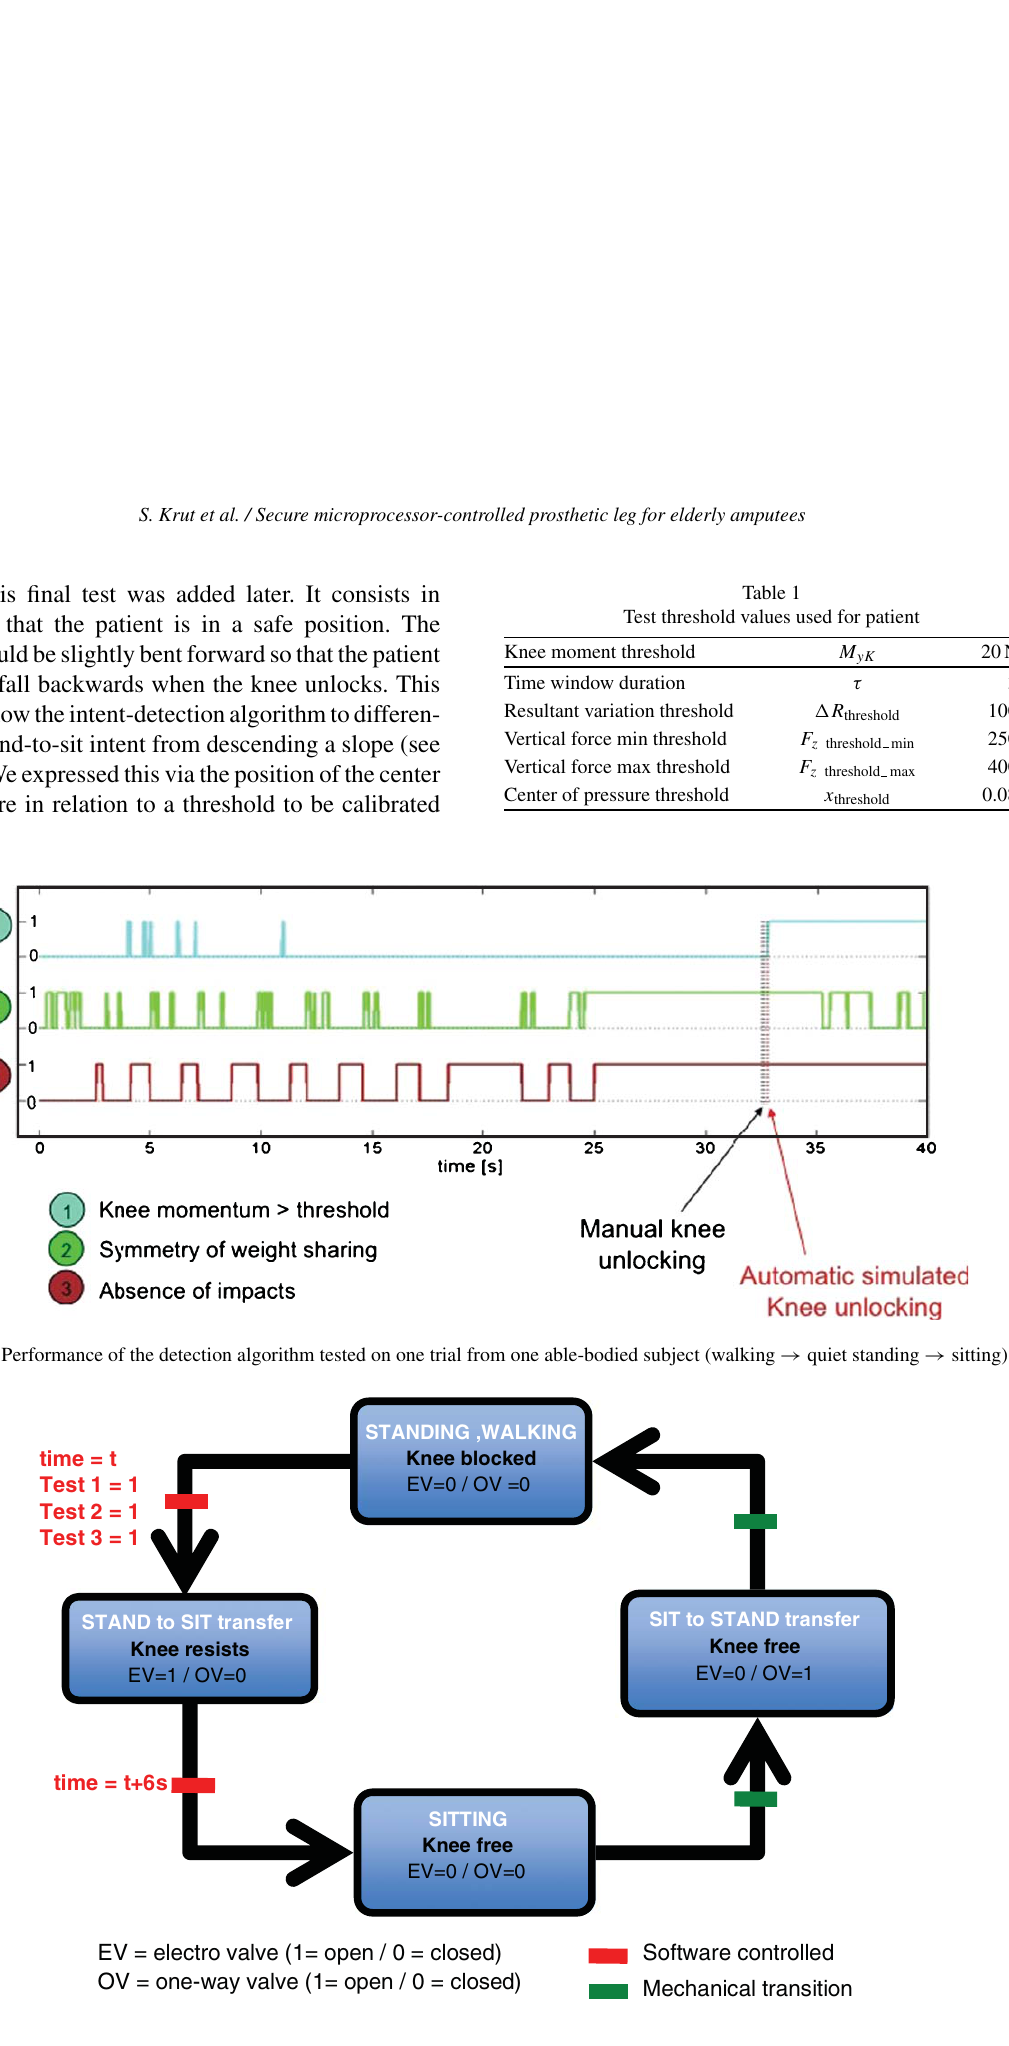
Fig. 11. States and transitions scheme of the intent detection